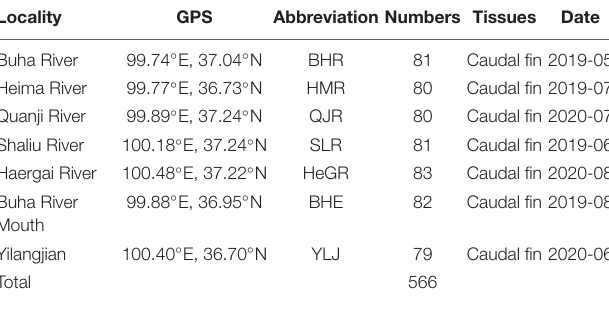
TABLE 1 | Details for sampling sites and quantities of Gymnocypris przewalskii